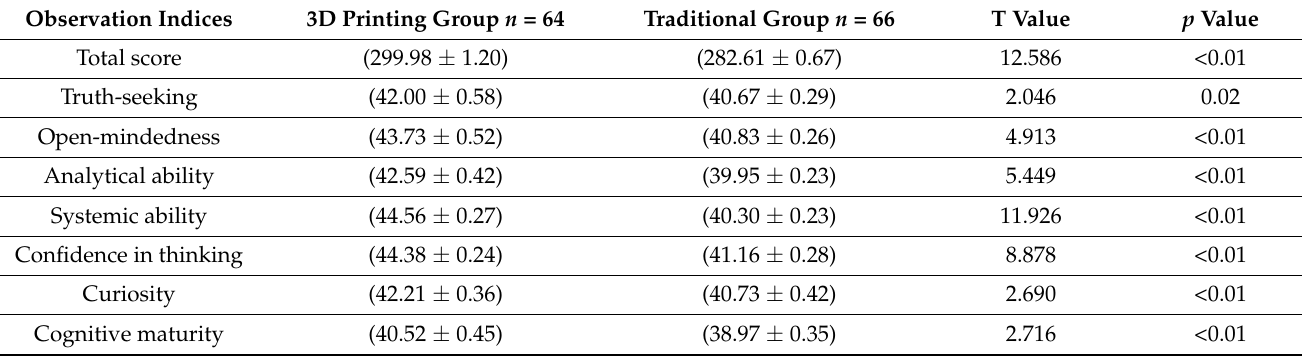
Table 2. The comparison of the results of critical thinking ability assessment between the two groups of nursing students [point, ([x — ± s]). Reprinted with permission under the open access from Tan et al.